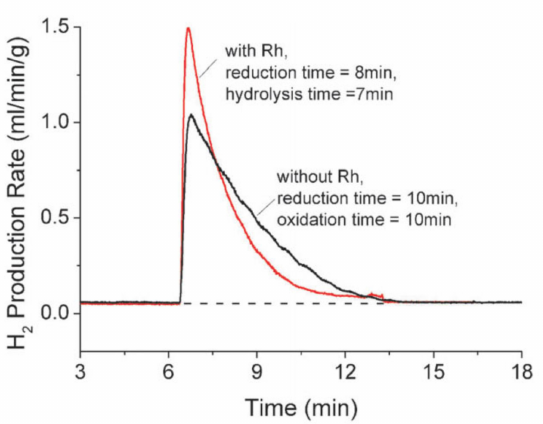
Figure 14. Effects of rhodium added to cerium (IV) oxide on the reduction and oxidation times, as well as on the hydrogen production rate during isothermal cycling at a temperature of 1500 ◦ C. Reprinted from